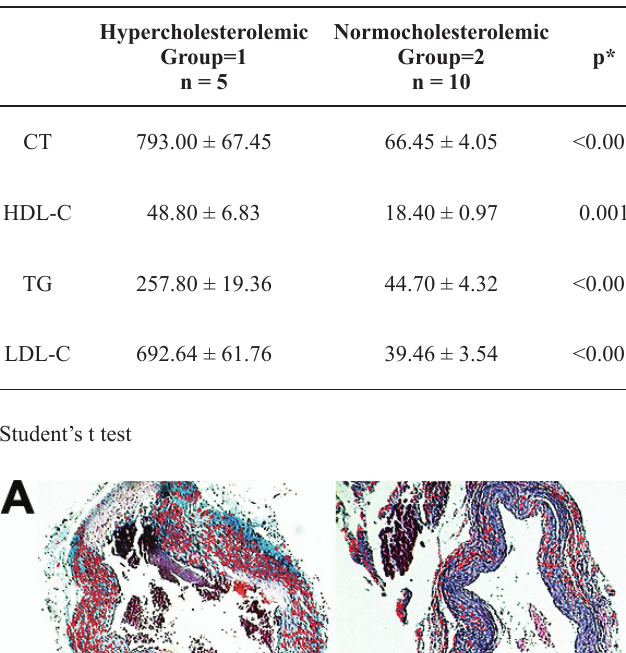
TABLE 1 - Blood levels of lipoproteins in rabbits from groups 1 and 2 on the 30 th day of pregnancy, when caesarian sections were performed. Results (mg/dl blood) are presented as mean ± standard deviation.